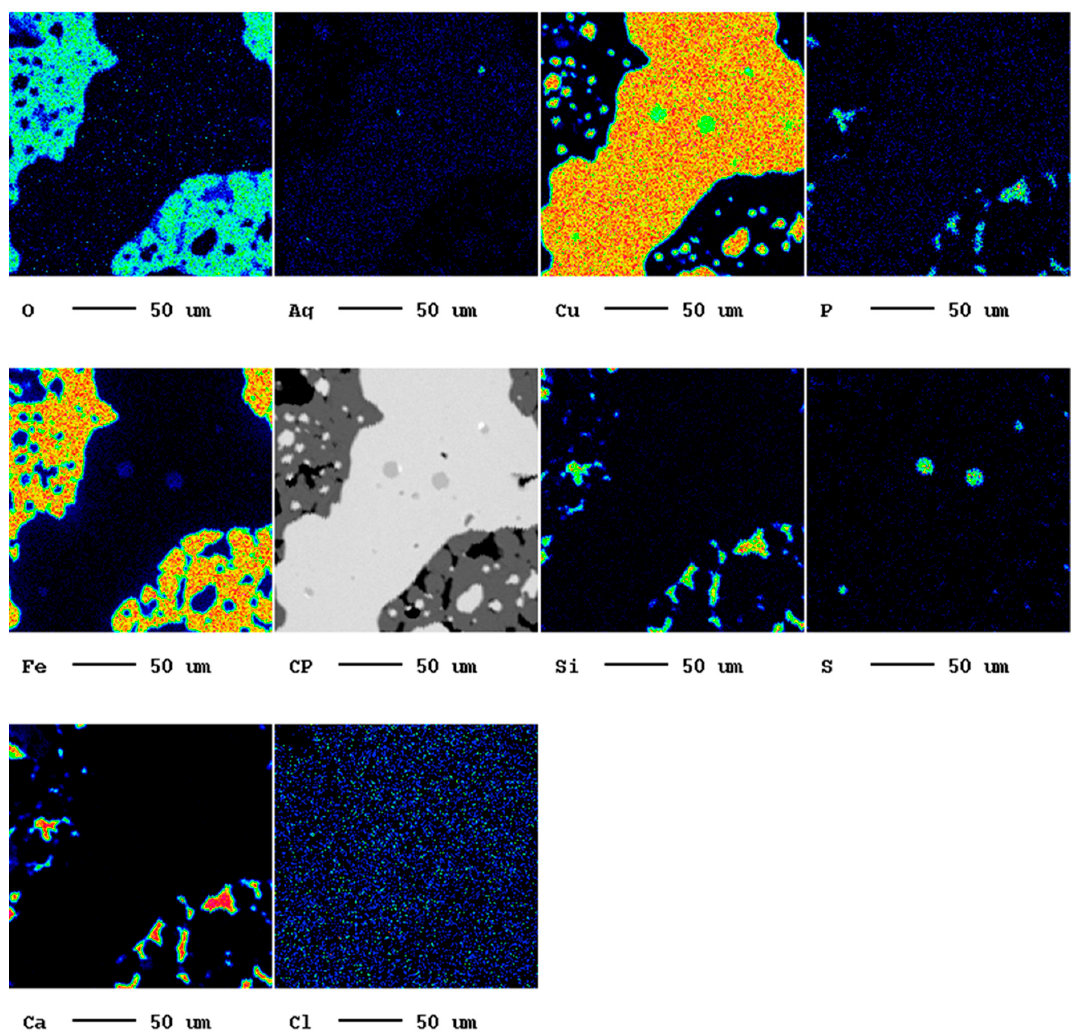
Figure 9. Elemental mappings of the same observed area the thermally treated abrasion product of sample A.